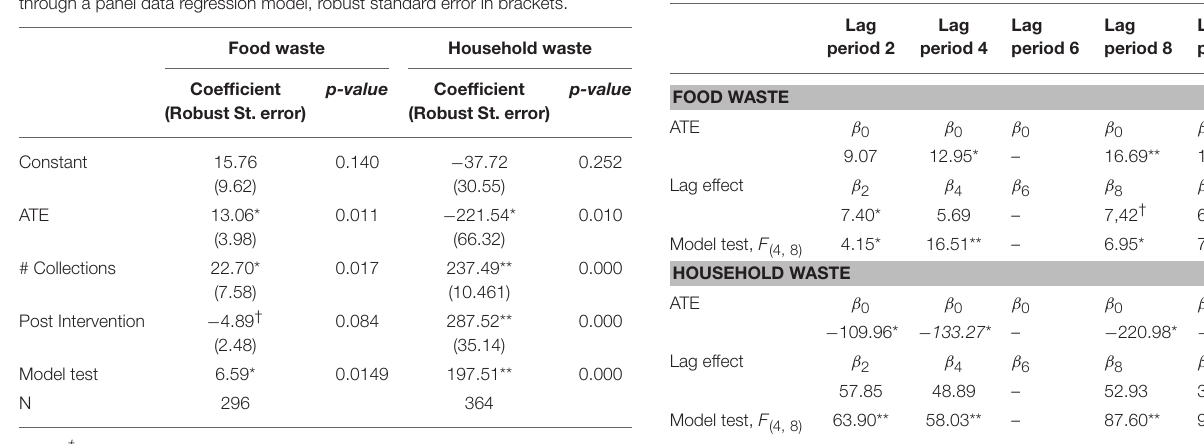
TABLE 4 | Behavioural pattern over time for food and household